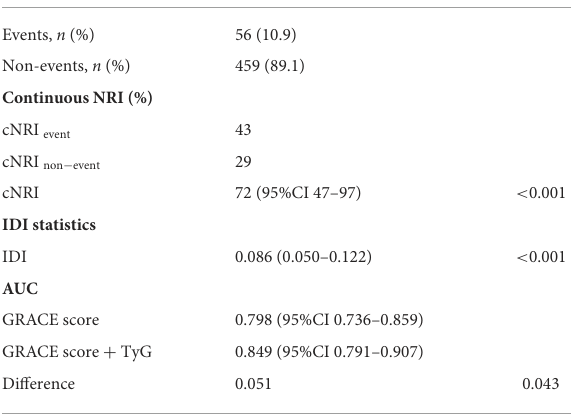
TABLE 2 Statistics for model improvement with the addition of the TyG